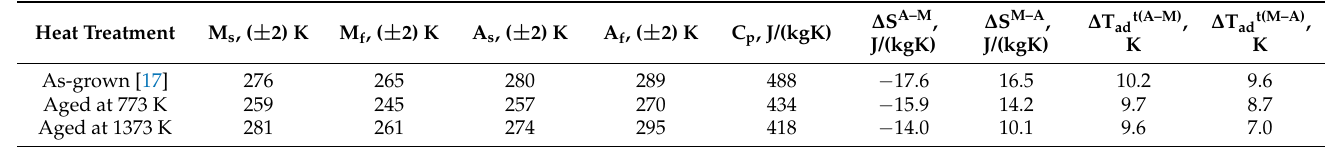
Figure 2. TEM image of the microstructure in the Ni 54 Fe 19 Ga 27 single crystals aged at 1373 K for 0.5 h: BF image of matrix and particles ( a – c ) and the selected area diffraction patterns (area is indicated in ( a )) from γ′ -phase particles with an ordered L1 2 structure ( d ). Table 1. Characteristic parameters of MT and heat characteristics from DSC response for [001]-single crystals Ni 54 Fe 19 Ga